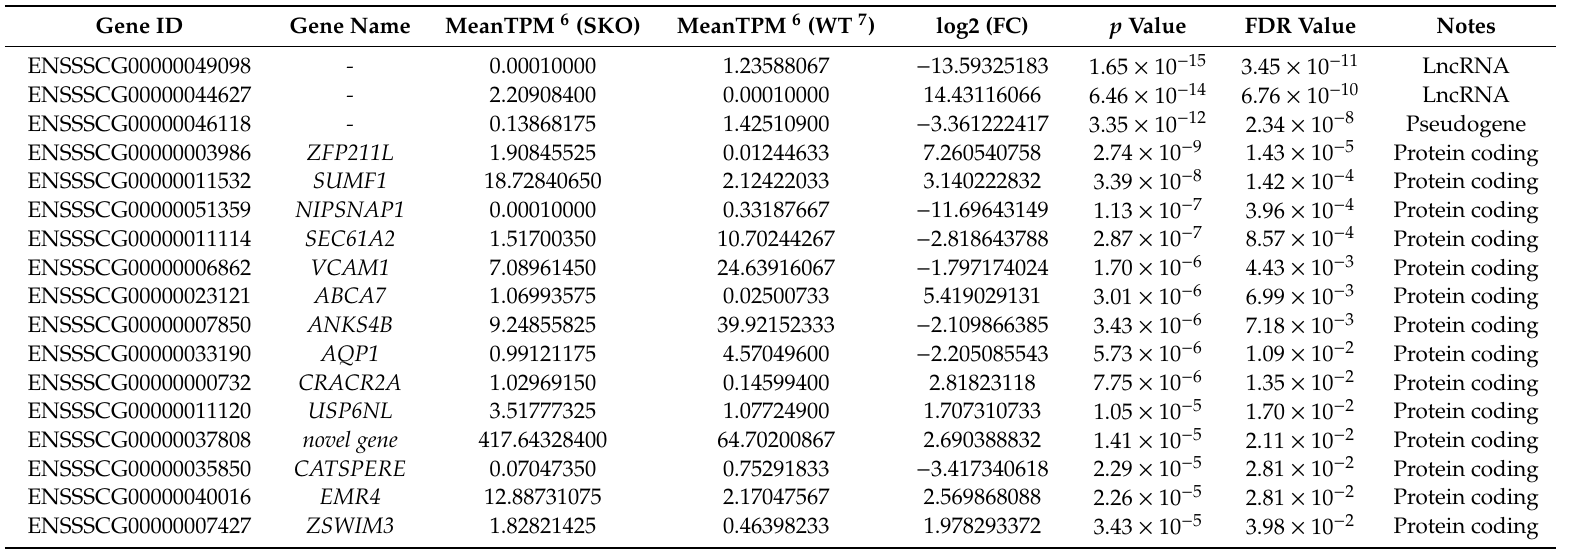
Table 3. DEGs 1 (FDR 2 < 0.05, FC 3 > 2) of ZBED6 4 -SKO 5 pig liver using